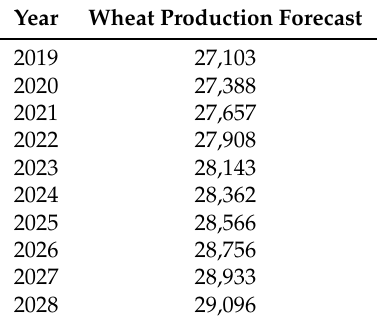
Table 6. Ten years ahead wheat production forecasting (in thousand tons) of Pakistan.